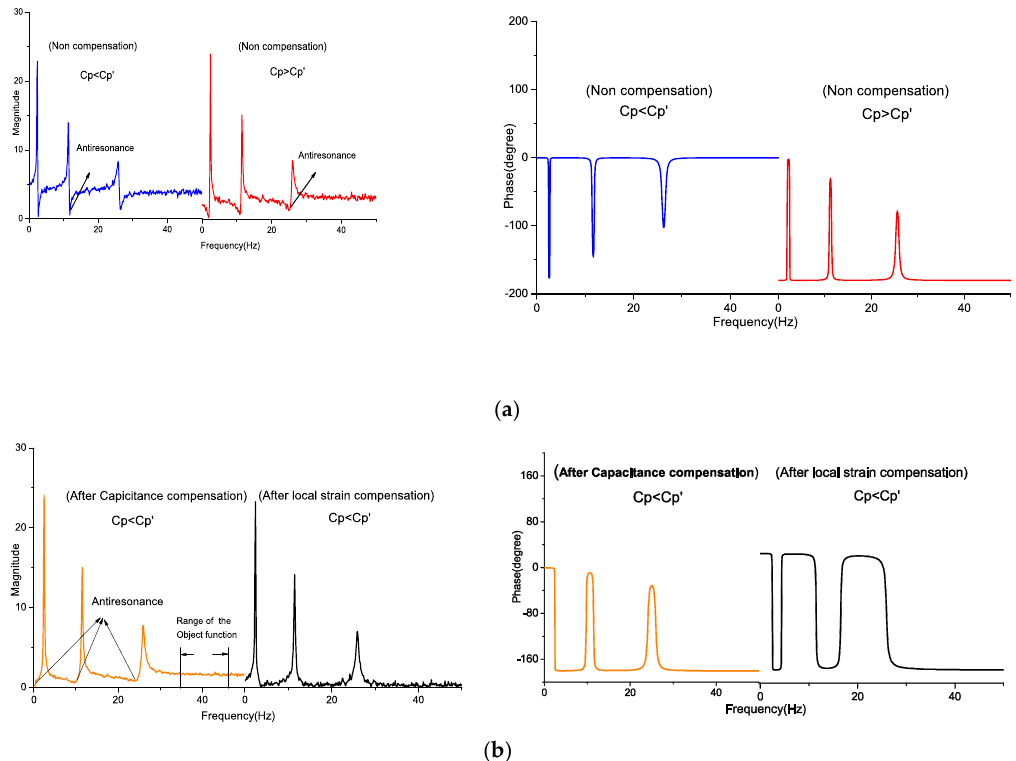
Figure 9. Frequency response function of bridge unbalance circuit ( a ) with no compensation, and ( b ) with feedforward compensation.